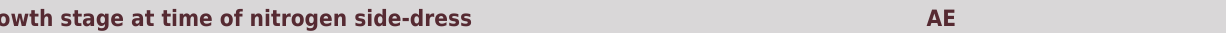
Table 7. Agronomic nitrogen use efficiency (AE) of two corn hybrids as affected by the growth stage of nitrogen side-dress fertilization in Lages, Santa Catarina, Brazil Growth stage at time of nitrogen